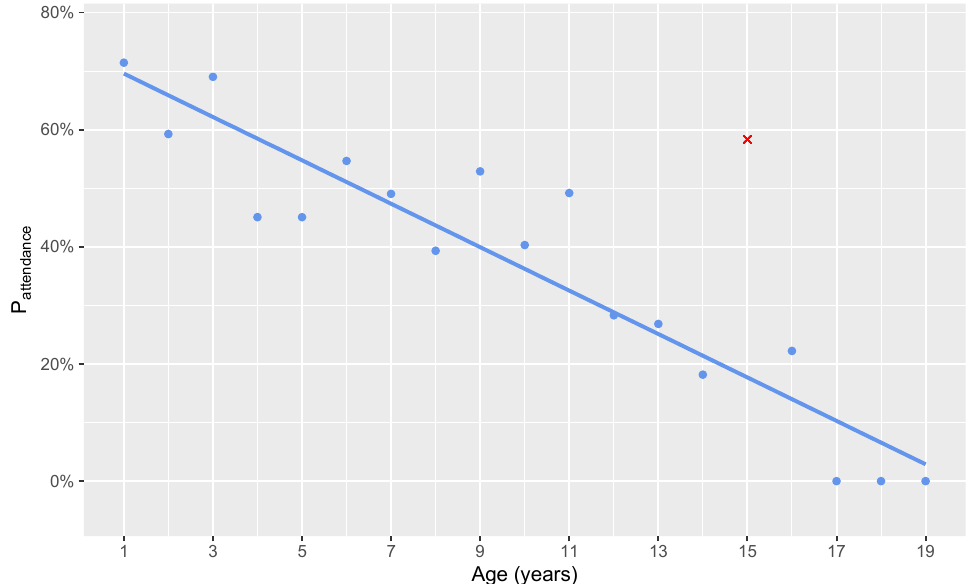
Figure 1. A smooth geometric means plot for the probability of training attendance at 6 months of age or younger versus the current age of the dog in years. The sole outlier has been marked in red to indicate its exclusion from the model.